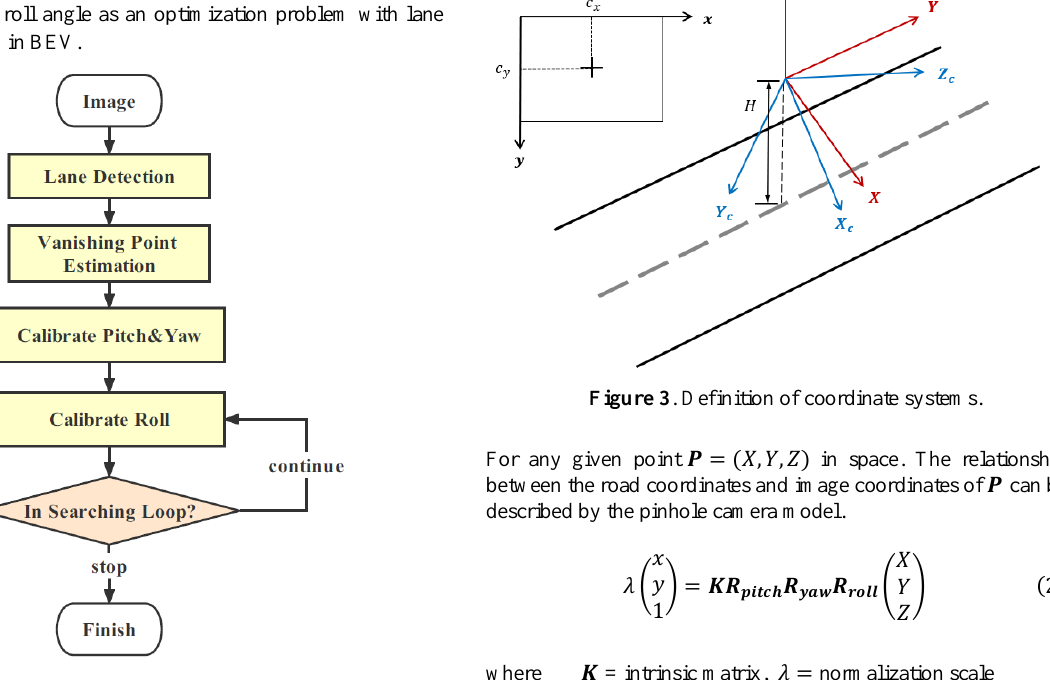
Figure 2 . Flow chart of the proposed